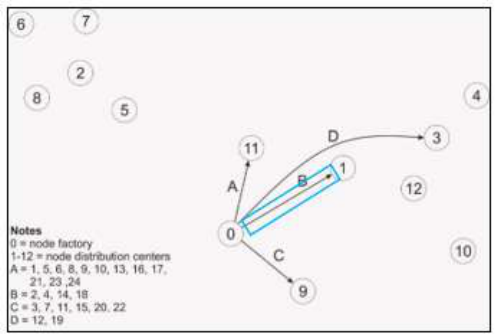
Fig. 5 Route representation for forward logistic Fig. 6 Route representation for reverse